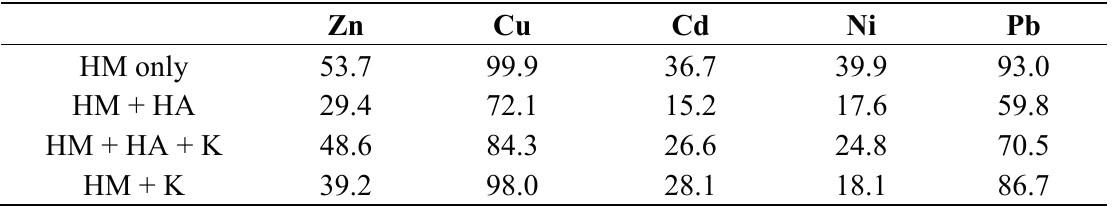
Table 2. Effects of humic acid (HA) and kaolinite (K) on the percentages * of cumulative removals of heavy metals (HM) by GAC (Influent concentrations (mg/L): Zn 1.80,